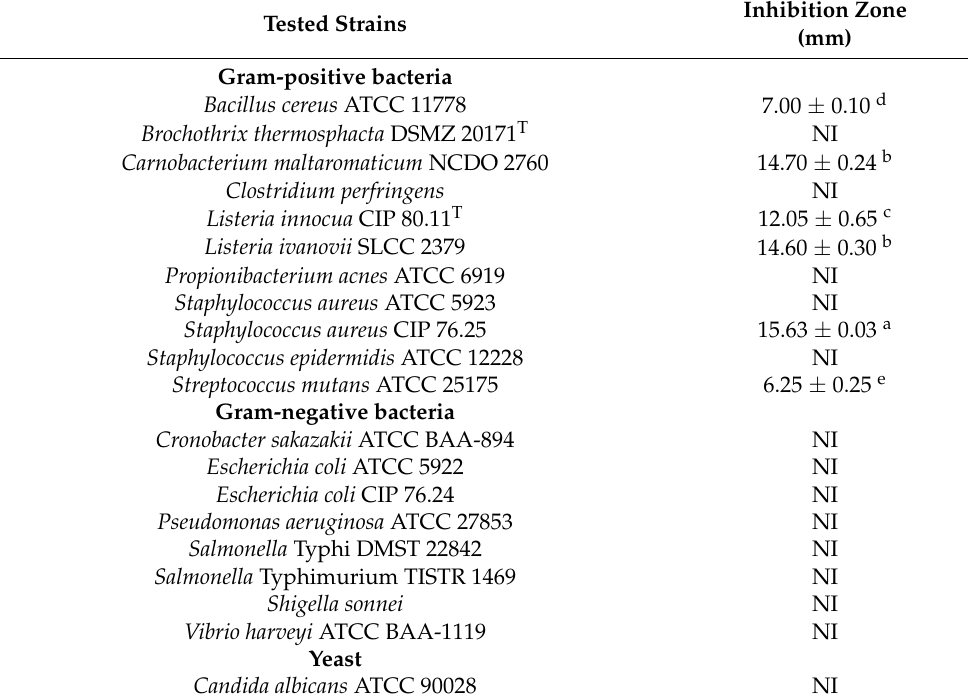
Table 2. The antimicrobial activity of CFS produced by E. faecium OV3-6. Tested